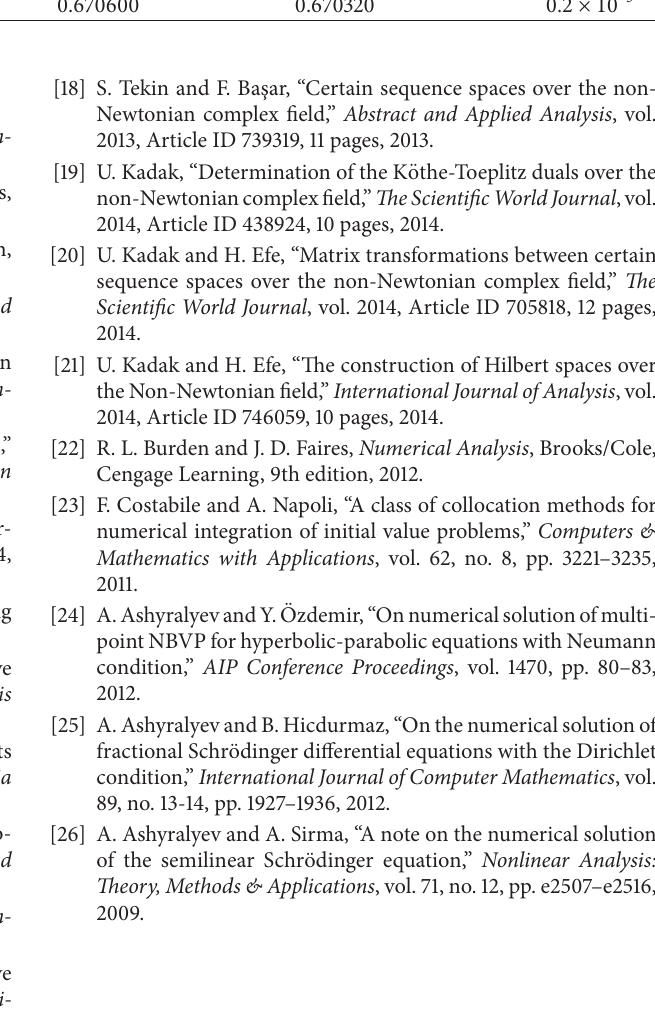
Table 4: Comparison of the results of the QRK